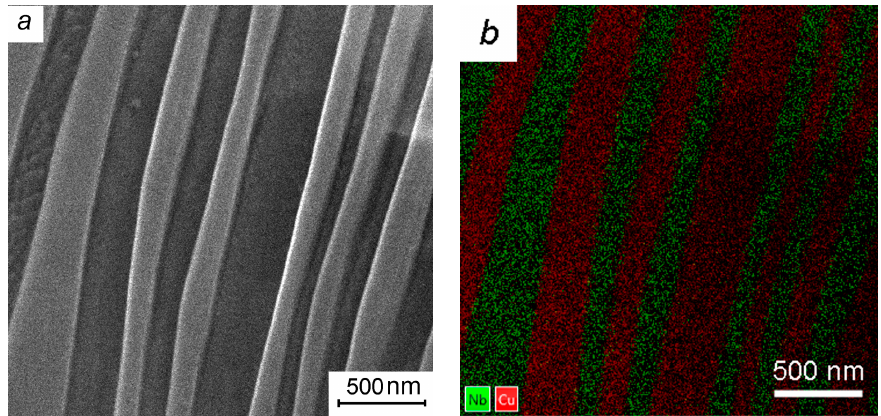
Figure 11. Structure of the cross section of Cu-Nb composite as-fabricated by multiple pack rolling (MPR) ( N = 0): bright-field scanning transmission electron microscopy (BF-STEM) image ( a ), energy dispersive X-ray spectroscopy (EDS) mapping ( b ).